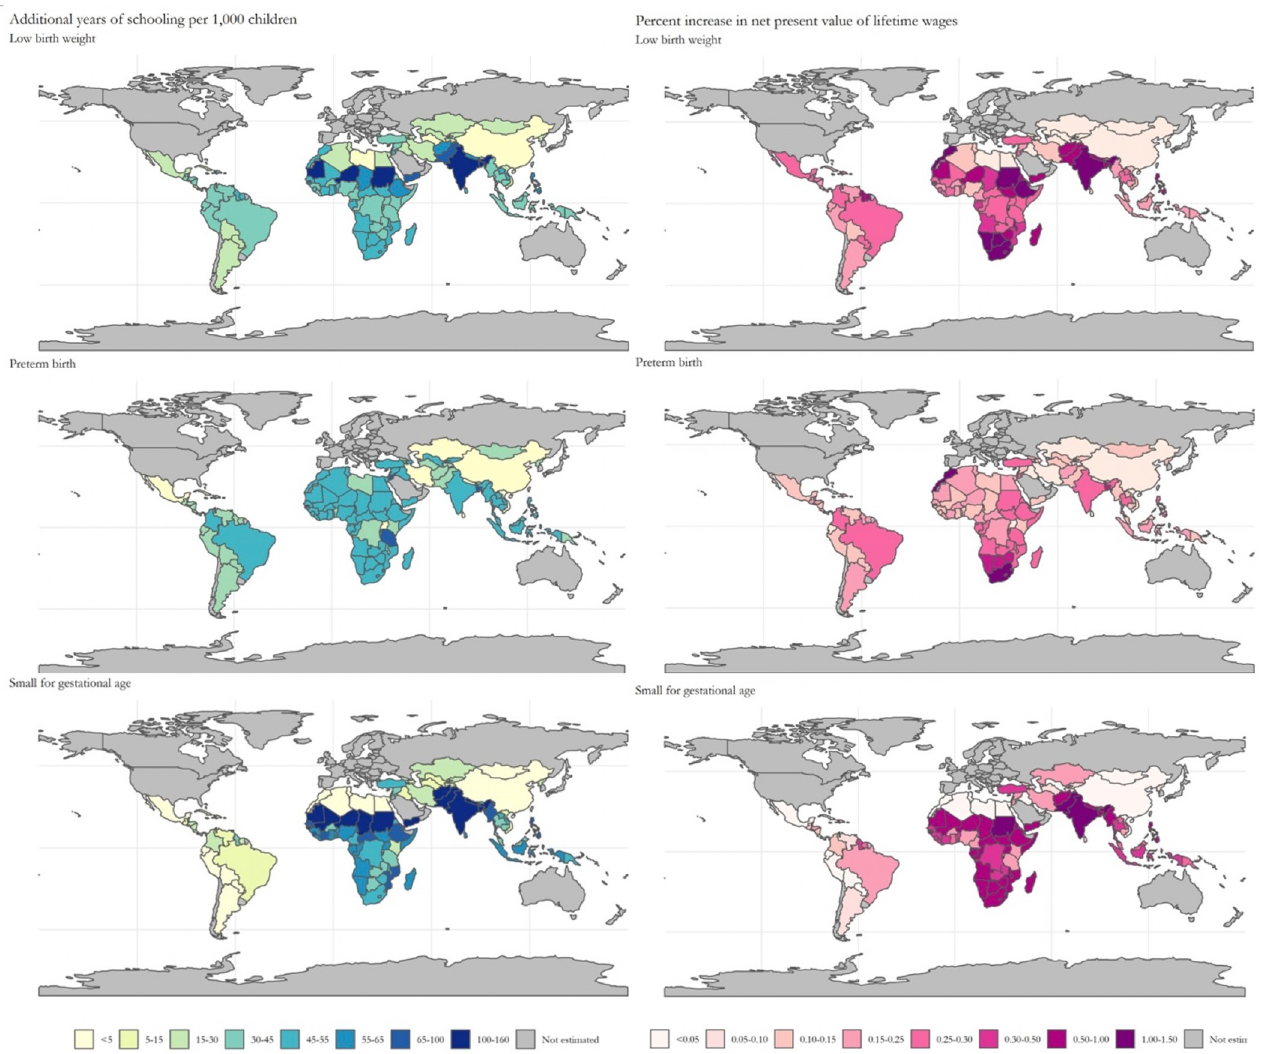
Fig 1. Absolute gains in schooling and relative increase in annual income by country. Maps were made using the spData package in R and basemaps from https://www.naturalearthdata.com/.